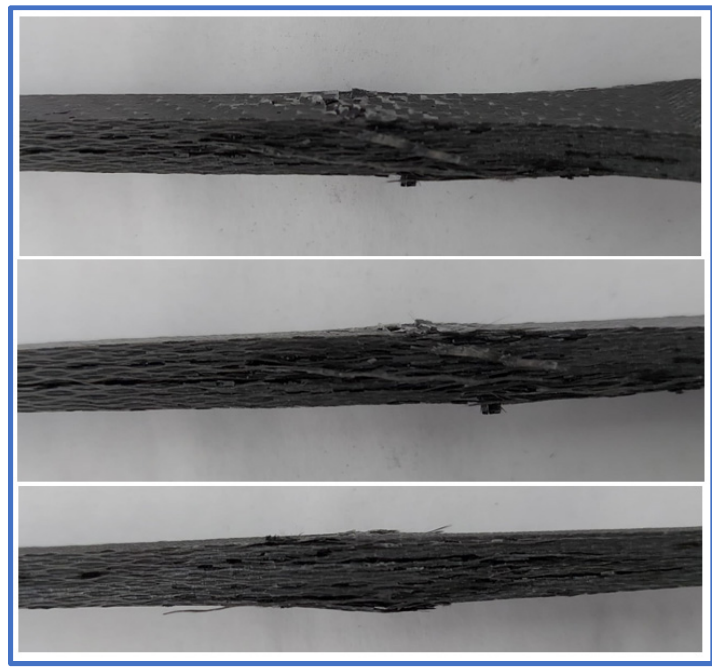
Figure 11. Material failure localization on the tensile test